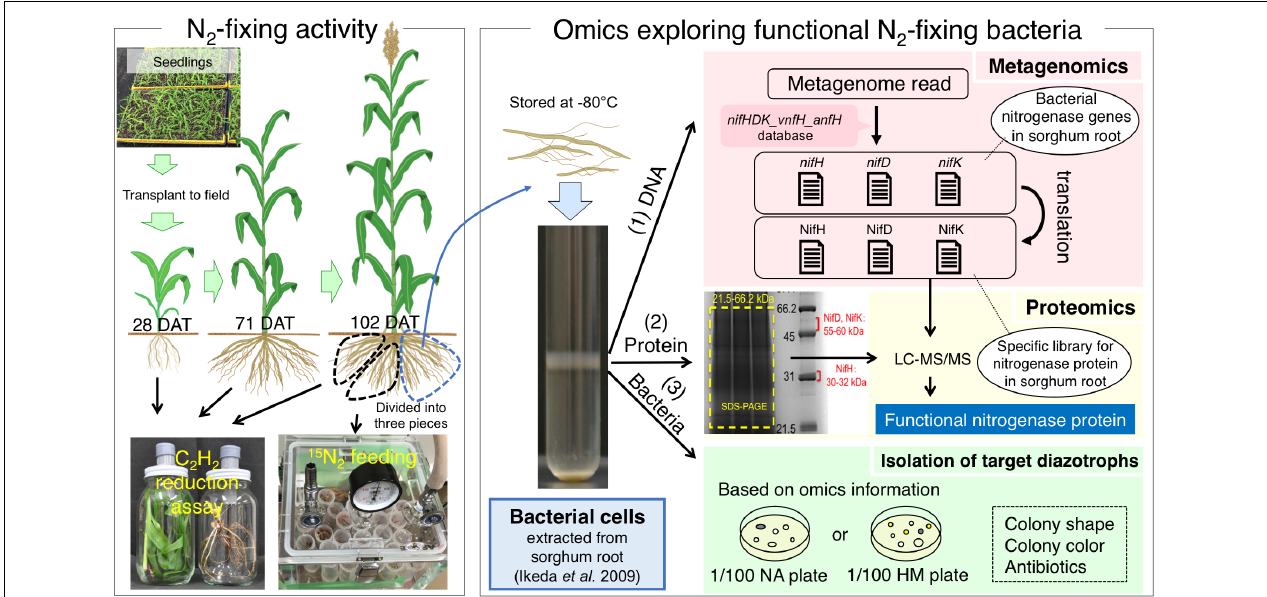
FIGURE 1 | Outline of “omics” strategy used to explore and identify functional N 2 -fixing bacteria associated with sorghum plants. N 2 -fixing activities were monitored in tissues of sorghum at different growth stages by acetylene reduction assay and were directly confirmed in an 15 N 2 feeding experiment. Bacteria were extracted from sorghum root tissues with higher N 2 -fixing activities, and their metagenomes (1) and proteomes (2) were analyzed. Functional N 2 -fixing bacteria were isolated from the extracted bacteria (3). DAT = days after